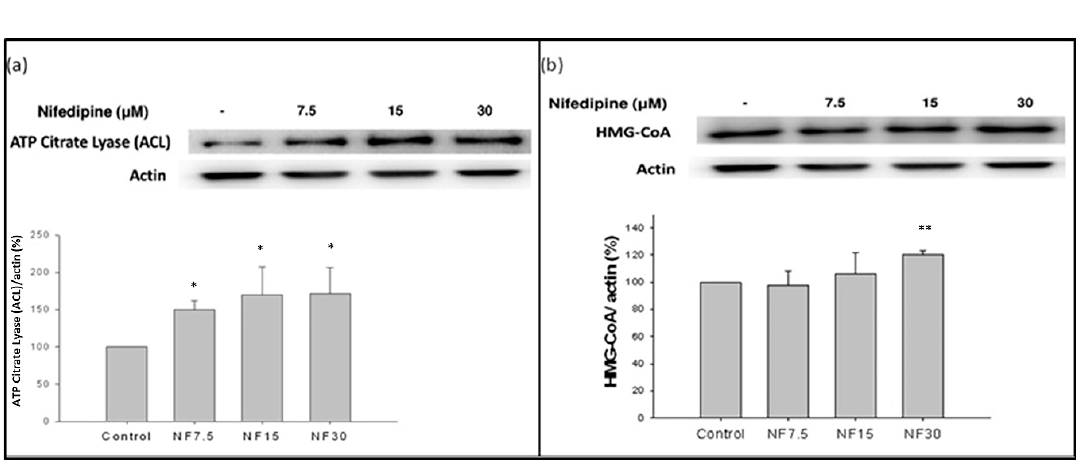
Figure 5. Nifedipine stimulated de novo lipogenesis-2 in 48 h: ( a ) the ACL was stimulated by nifedipine in a dose dependent manner to 150%, 169%, 170% by 7.5, 15, and 30 µM, respectively, compared to the control ( p < 0.05); and ( b ) the HMG-CoA reductase was also upregulated by nifedipine administration in a dose-dependent fashion up to 107% and 120% at 15 and 30 µM ( p < 0.05). p -values ≤ 0.05 (marked as *) were considered statistically significant. In addition, p -values ≤ 0.01 are marked as **.